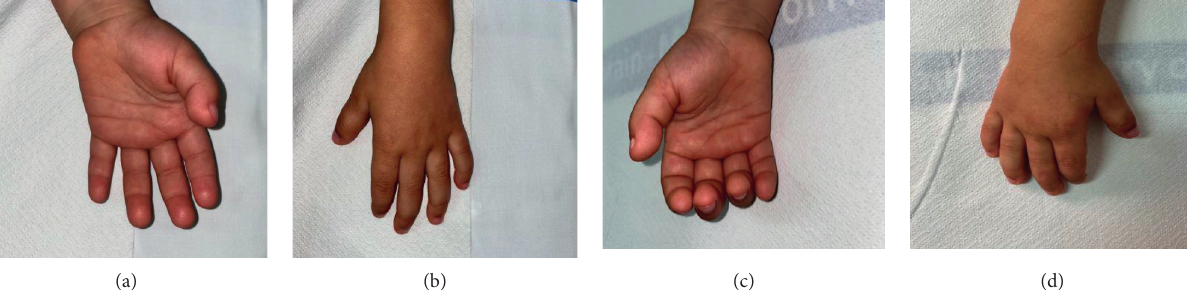
Figure 2: Patient’s hands showing short fingers.